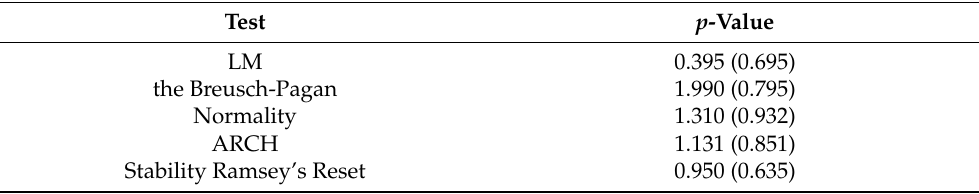
Table 6. Findings of the diagnostic